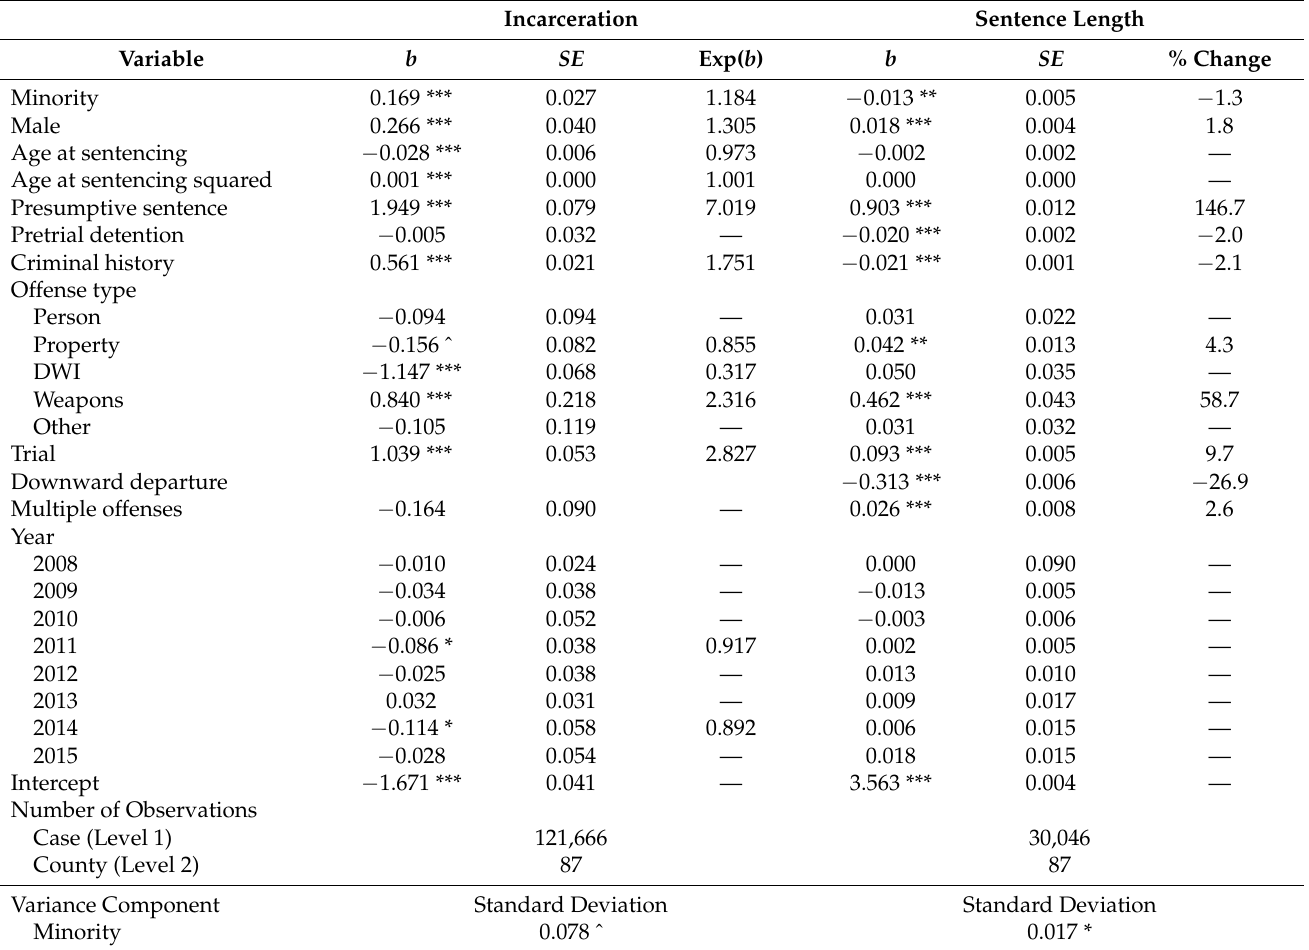
Table 2. Hierarchical Regression of Incarceration and Sentence Length, 2007–2015 Case-Level